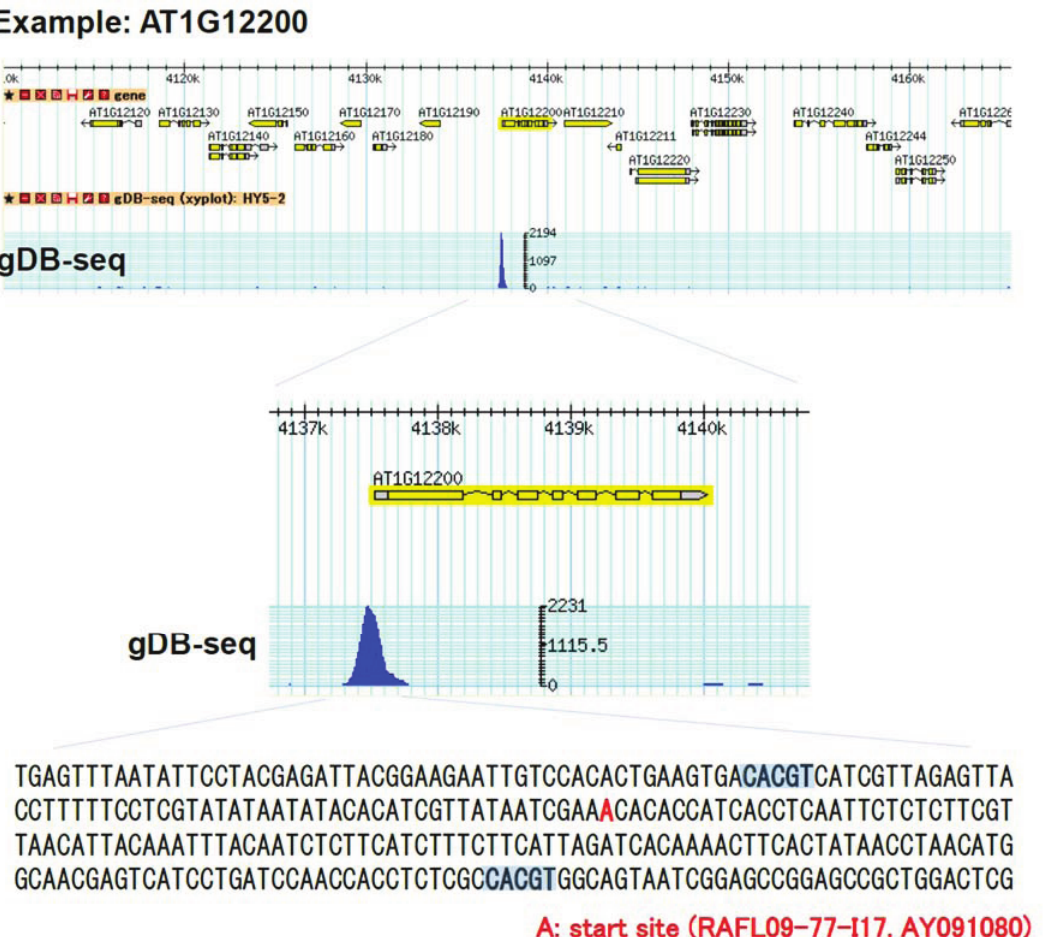
Figure 4. Genome browser view of an example of gDB-seq. There is one peak at the promoter of the AT1G12200 gene. Sequence around this peak contains two predicted motifs (CACGT). Peak score = 218.0. The HY5 gDB-seq data can be visualized using GBrowse located at